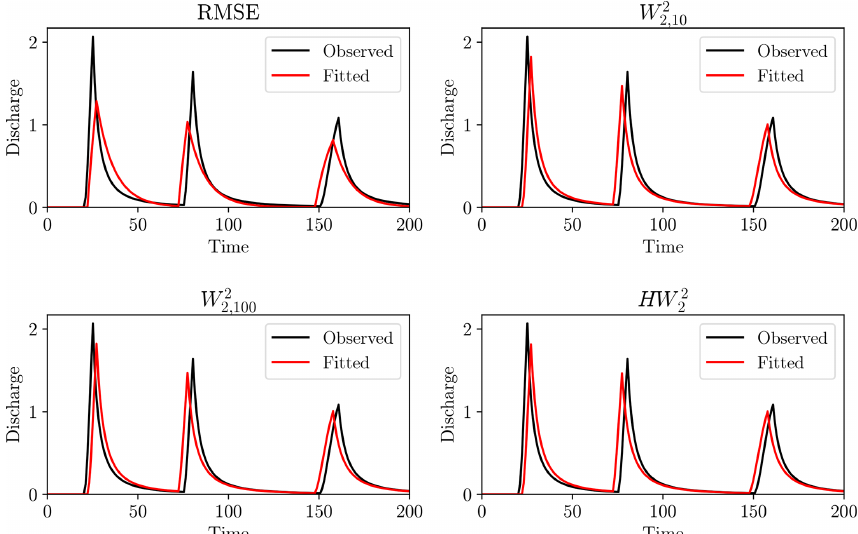
Figure 14. Output of the rainfall–runoff model for calibrated parameters under each objective function. Observations displayed in black and simulation in